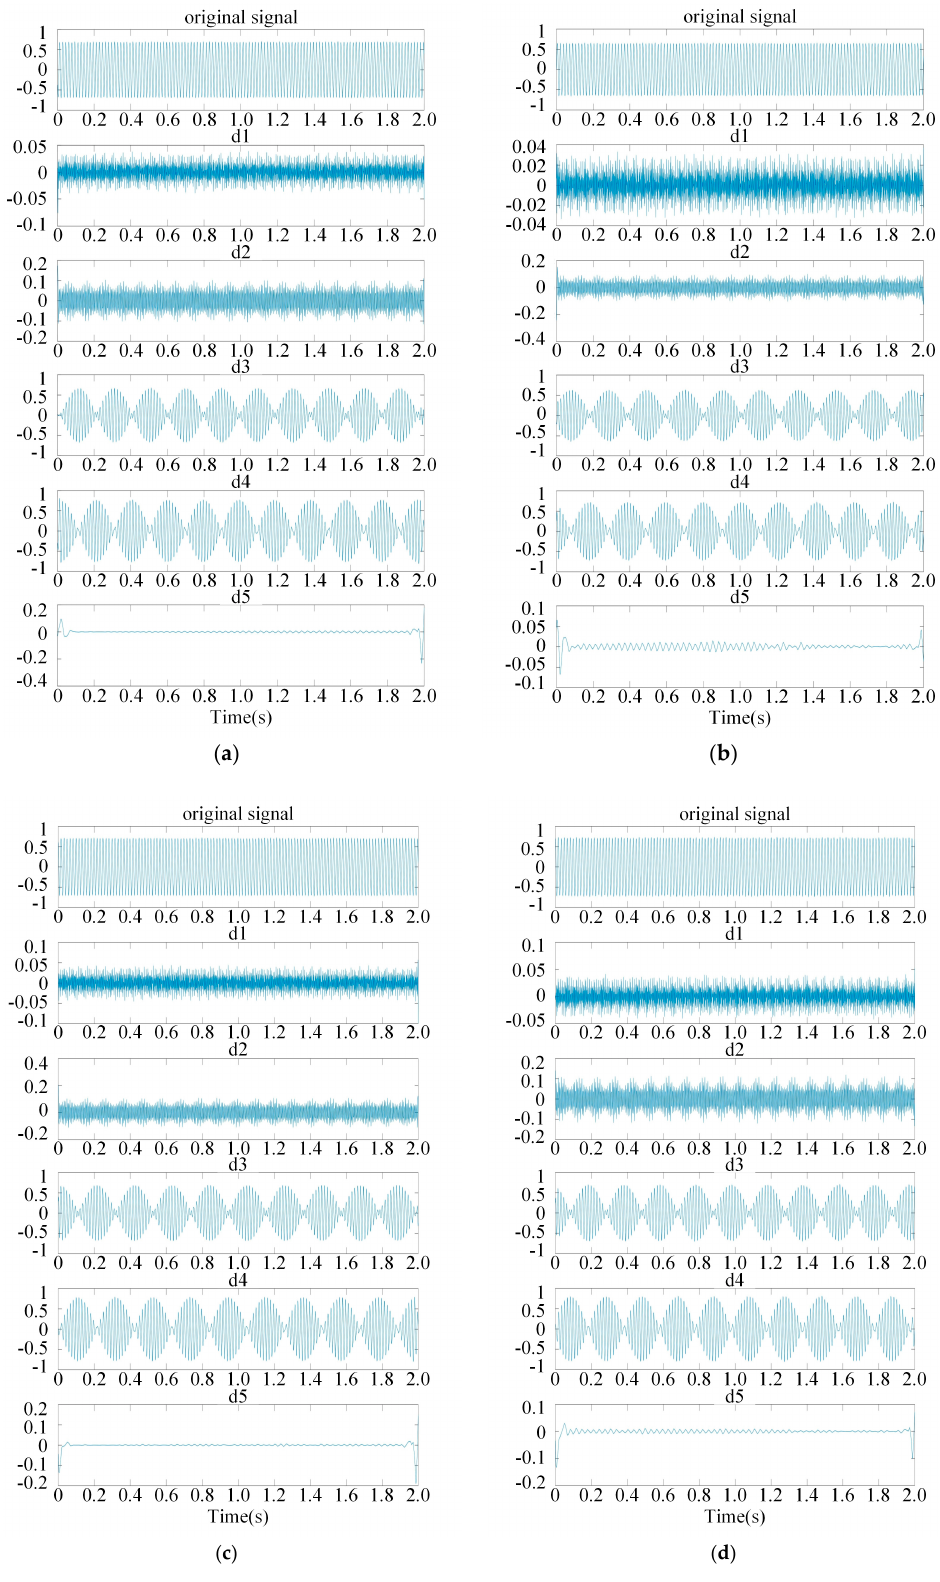
Figure 10. MRA of current signal of ( a ) healthy motor; ( b ) bearing damage motor; ( c ) stator short circuit motor; ( d ) broken rotor bar